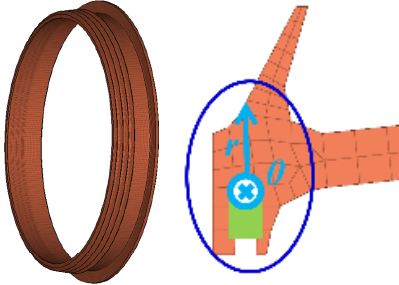
Figure 18. Labyrinth seal ‐ ring dry friction system.